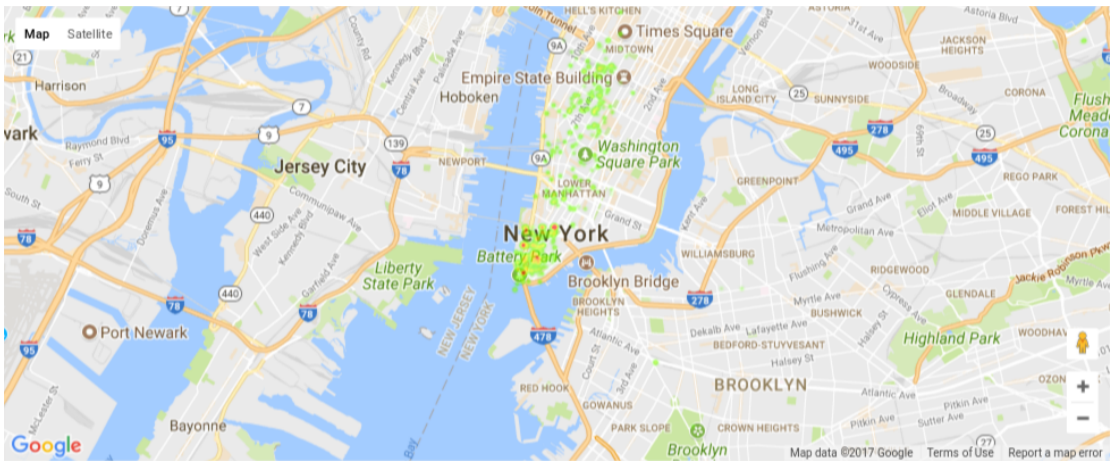
Figure 10. Priority distribution in Weeks 6 and